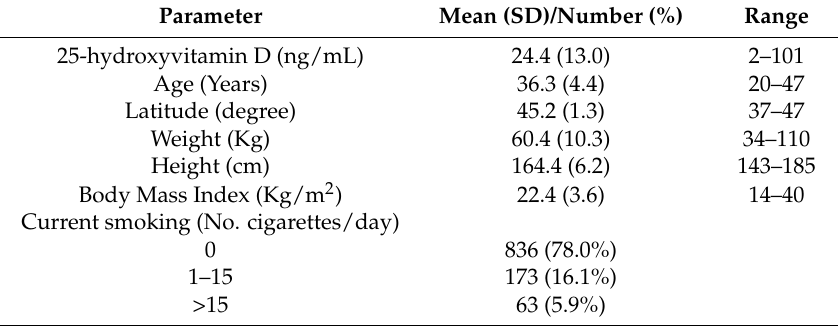
Table 1. Descriptive characteristics of women included in the study. Latitude was converted